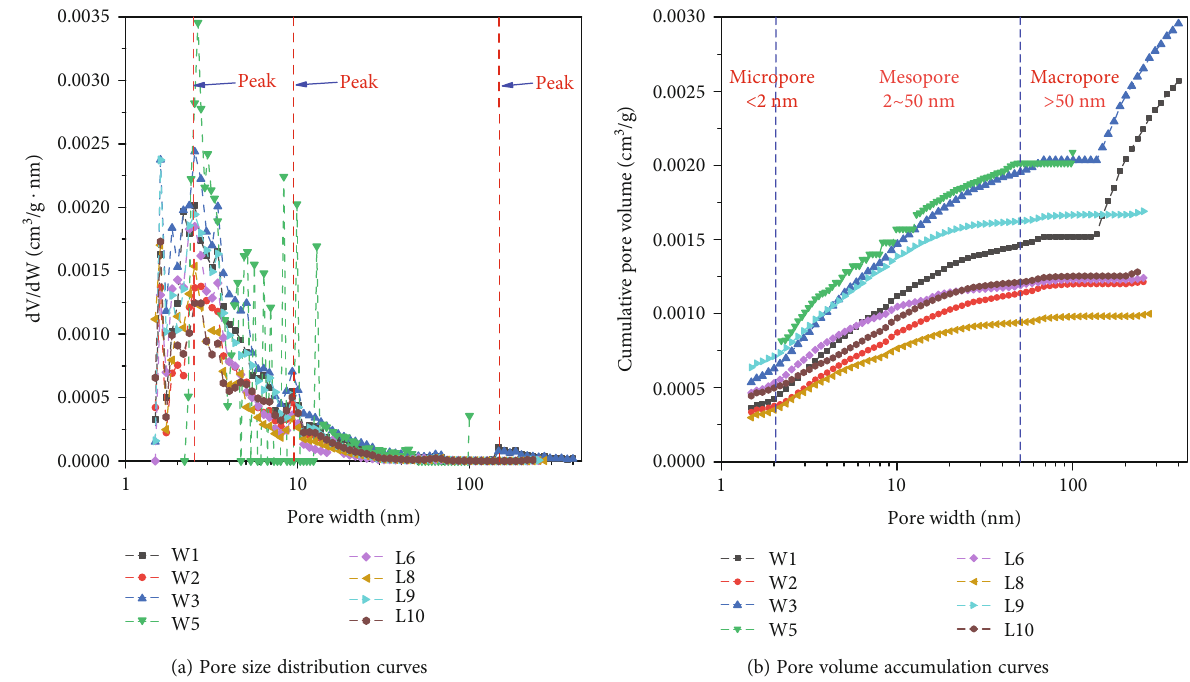
Figure 3: Pore structure characteristics of the deep Longmaxi Formation deep